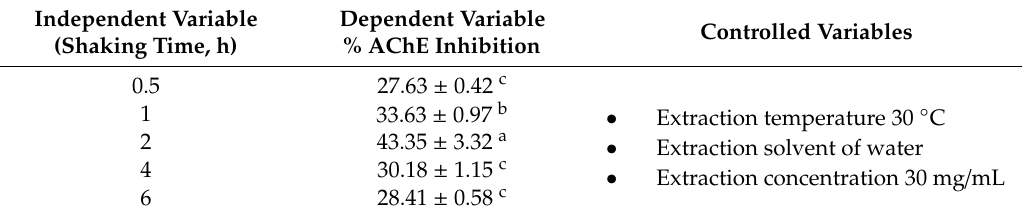
Table 2. E ff ects of di ff erent shaking times on MNCM extraction regarding AChE inhibition.